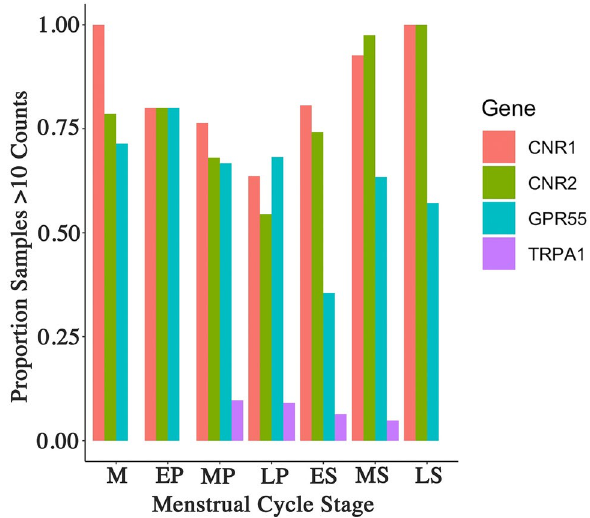
Figure 4. Logistic regression analysis of endocannabinoid receptor. Four of the five endocannabinoid receptor did not show consistent expression above > 90% in all samples. A logistic regression analysis examining the percentage of samples displaying a positive expression showed significant variation across the menstrual cycle for CNR1, CNR2 and GPR55. Only a small number of samples expressed TRPA1 and this was limited to the period between the mid proliferative to mid secretory stage. M = Menstrual, EP = Early proliferative, MP = Mid proliferative, LP = Late proliferative, ES = Early secretory, MS = Mid secretory, LS = Late